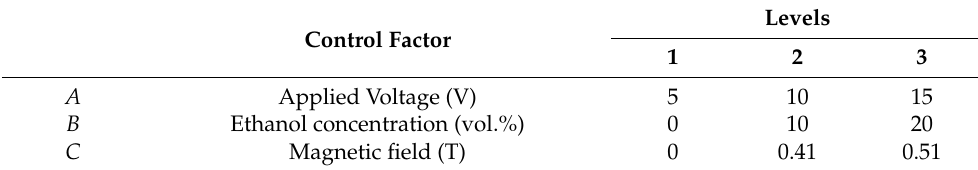
Table 6. Factors and levels of the EP machining